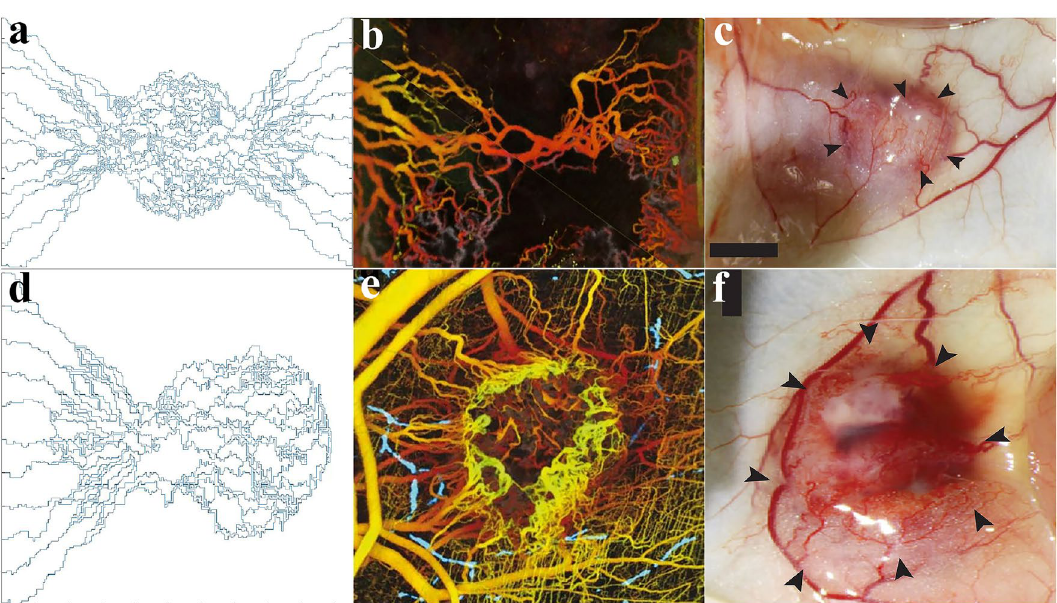
Figure 6. Biological validation of the angiogenesis modeling. ( a ) Our simulations show that the branching of new vessels occurs near the tumor boundary and inside the tumor; in vivo observations of tumor angiogenesis by ( b ) Vakoc et al. 53 and ( c ) Roudnicky et al. 54 . ( d ) The sprouting angiogenesis induced by one parent vessel form vascular loops; and in vivo observations of tumor angiogenesis by ( e ) Vakoc et al. 53 and ( f ) Roudnicky et al. 54 . It should be mentioned that ( b ) and ( e ) are extracted from Vakoc et al. 53 with permissions. Additionally, ( c ) and ( f ) are taken from Roudnicky et al. 54 with